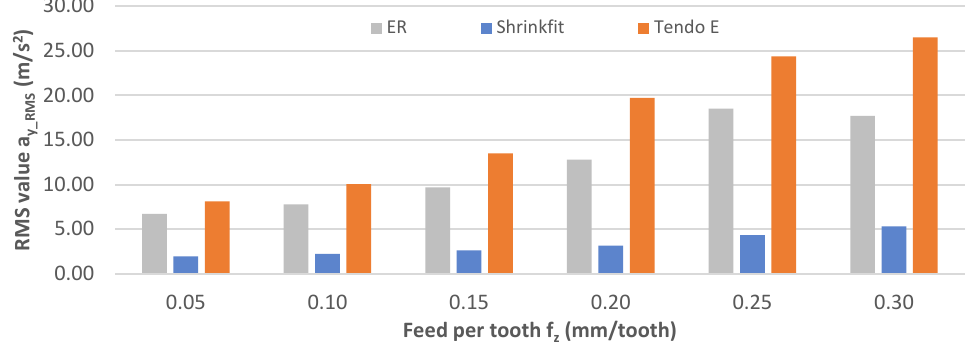
Figure 17. Impact of feed per tooth f z on rms vibration acceleration value a y_RMS (v c = 800 m/min, a p = 6 mm).